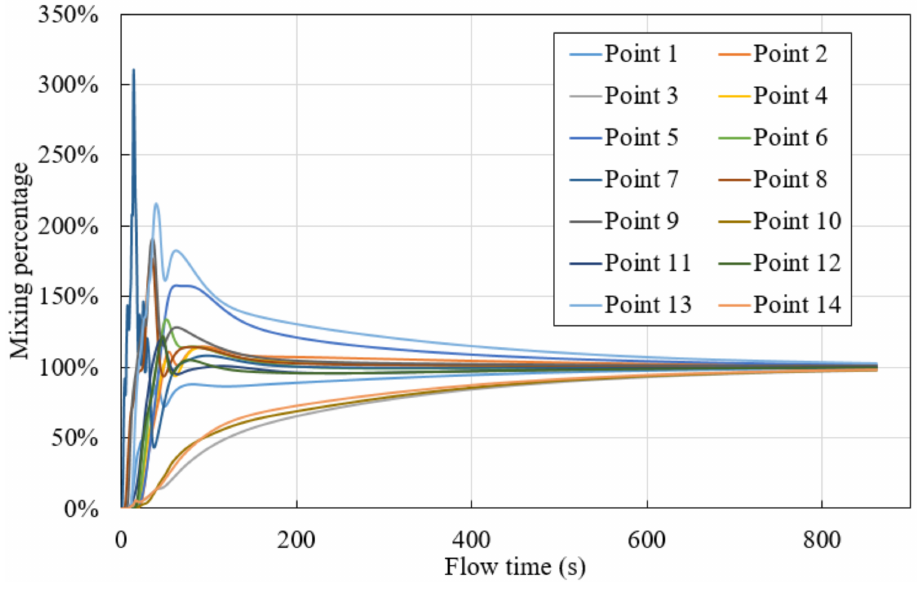
Figure 18. Point mixing percentage in case 1. Table 6. Mixing time for each